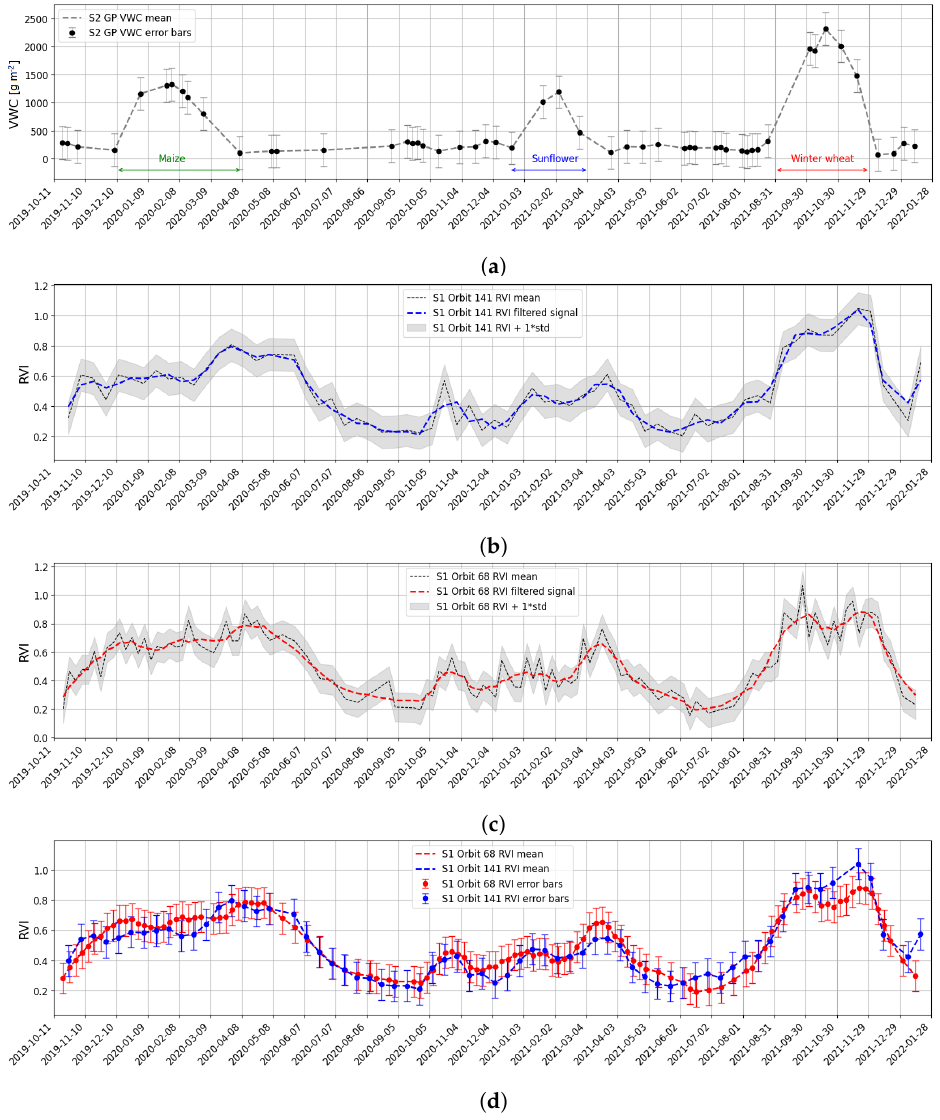
Figure 4. Temporal profiles (mean value and standard deviation) of averaged selected ROI-2 over a winter wheat parcel belonging to the BVCR 2021 crop campaign. S2 GP VWC time series from October 2019 to the end of January 2022 ( a ). S1 RVI orbit 141 smoothed (dashed blue line) and original (dashed black line) time series ( b ). S1 RVI orbit 68 smoothed (dashed red line) and original (dashed black line) time series ( c ). S1 RVI Orbit 68 (red line) and S1 orbit 141 (blue line) RVI time series ( d